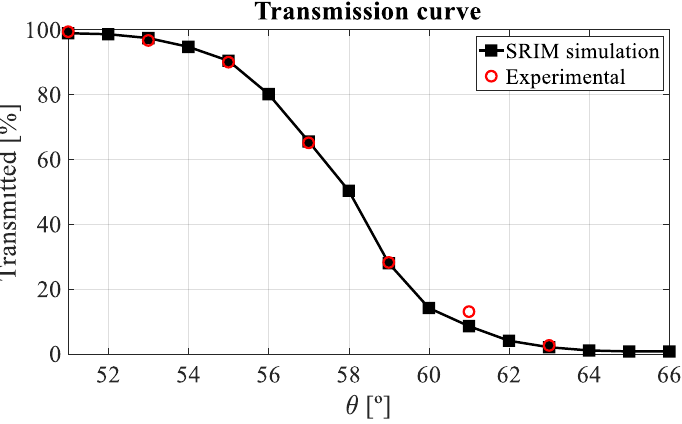
Figure 16. Experimental and theoretical (obtained with SRIM2013) transmission curves.